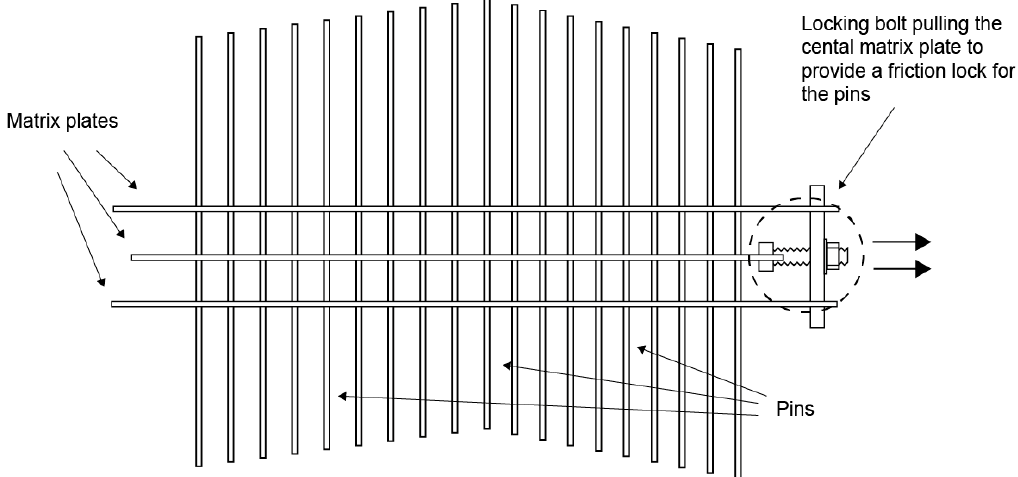
Figure 5. The improved pin locking mechanism used in the second design iteration of the round glass RPT device (illustration by Jorgensen, T. 2011).